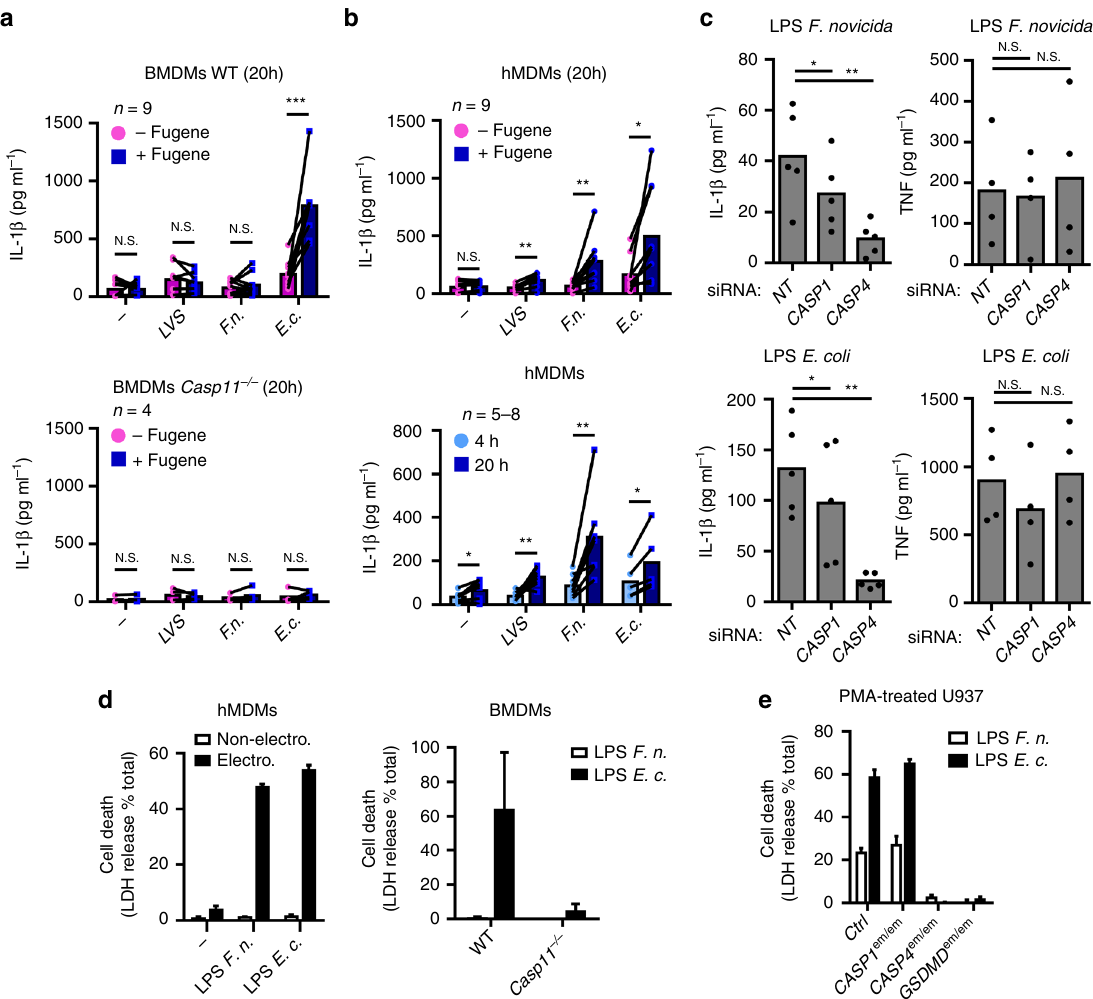
Fig. 4 Cytosolic LPS from F . novicida and F . tularensis activates the non-canonical in fl ammasome in a species-dependent manner. a BMDMs of the indicated genotype or b hMDMs were primed with Pam3CSK4 and treated (Magenta, − Fugene) or transfected (Blue, +Fugene) with FugeneHD alone ( − ) or with 5 µ g.mL -1 of lipopolysaccharide (LPS) from F . tularensis live vaccine strain ( LVS ), F . novicida ( F.n .), E. coli ( E.c .). IL-1 β levels were quanti fi ed by ELISA at 20 h or at the indicated time ( b , lower panel) post-transfection. c hMDMs were transfected with non-targeting (NT) siRNA or the indicated siRNA, primed with Pam3CSK4, and transfected with 5 μ g.mL -1 of the indicated LPS. IL-1 β and TNF levels were quanti fi ed by ELISA at 20 h post-transfection. d hMDMs, BMDMs and e U937 cell lines from the indicated genotypes were, as indicated, electroporated or not with 5 µ g of LPS from F . novicida ( F.n .) or E. coli ( E.c .). Cell death was assessed by measuring lactate dehydrogenase (LDH) release at 1 h (hMDMs) or 4 h (U937, BMDMs) post-electroporation. a – c Each point shows the mean value from three technical replicates for one a mouse or b , c healthy donor. The bar shows the mean for all donors ( n ≥ 4). a , b the lines show the pairing of the values for a single mouse or healthy donor with or without LPS transfection (+ or − FugeneHD) or ( b , lower panel) at 4 h and 20 h post-transfection. Two-tailed p values with the following nomenclature (*** p < 0.001, ** p < 0.01, and * p < 0.05 by paired t -test) are shown. N.S. not signi fi cant. d , e Mean values ± standard deviation from d two to e three independent experiments are